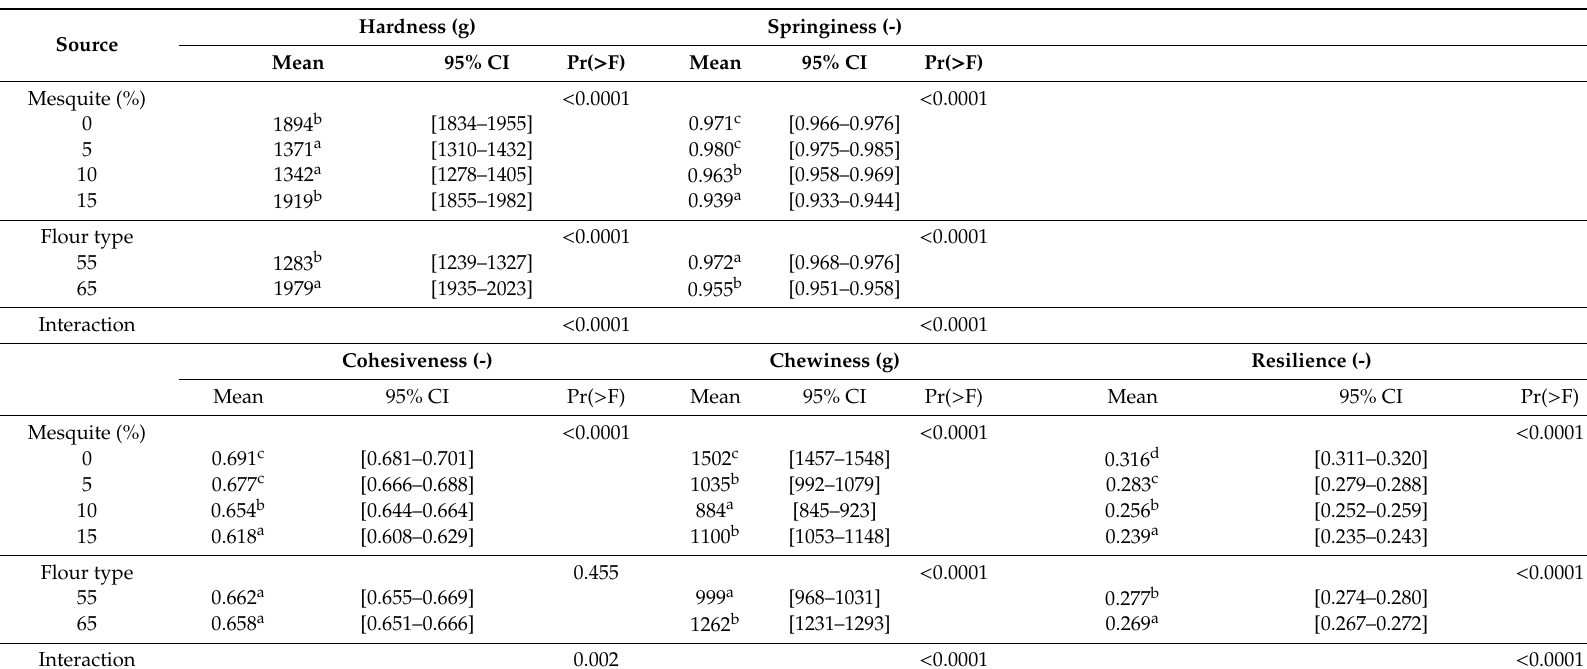
Table A3. Combined e ff ect of mesquite flour substitution level and wheat flour type on the texture profile analysis descriptors of composite bread crumb, showing means and 95% confidence